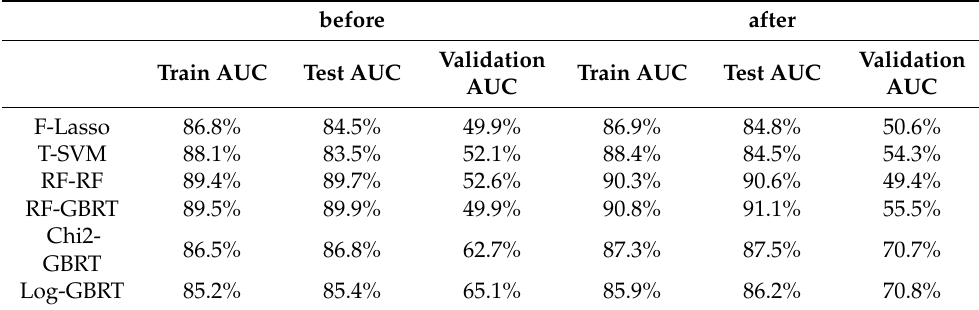
Table 1. The performance of models before and after adjusting the parameters.